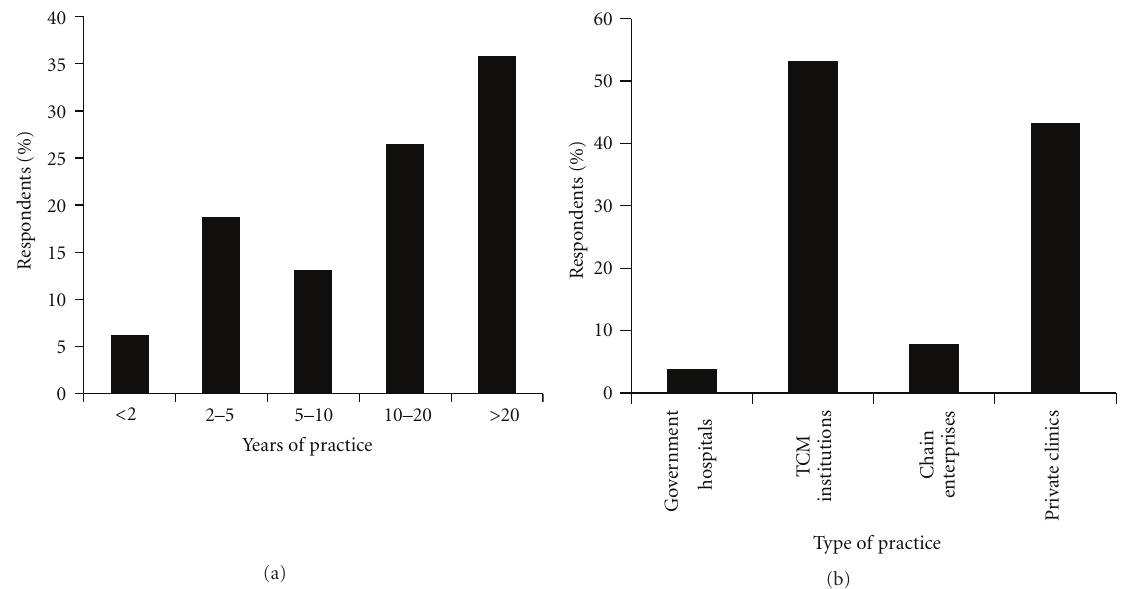
Figure 1: Demographics of surveyed TCM practitioners. Bar chart representing (a) number of years of practice among surveyed TCM practitioners and (b) place of practice of TCM practitioners. “Conventional hospitals” refer to places with mainly conventional medicine